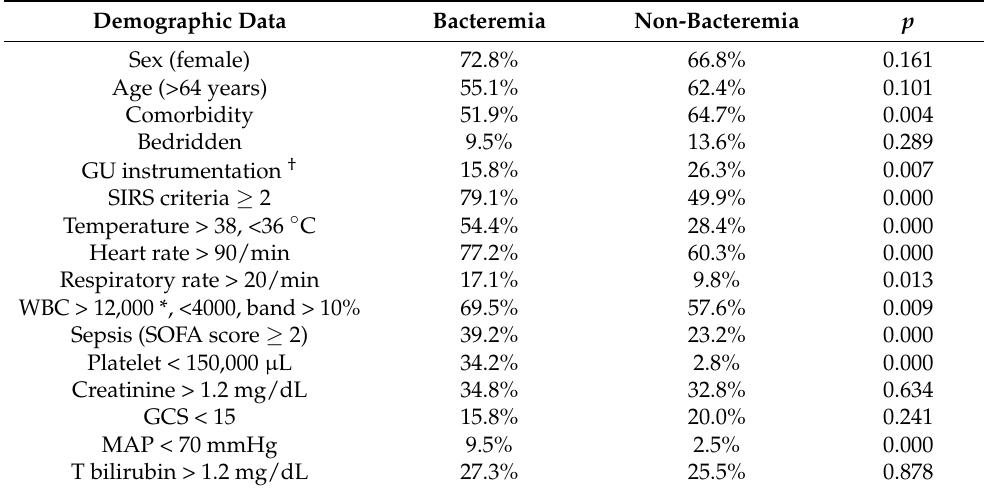
Table 1. Comparison between the bacteremia and non-bacteremia groups.